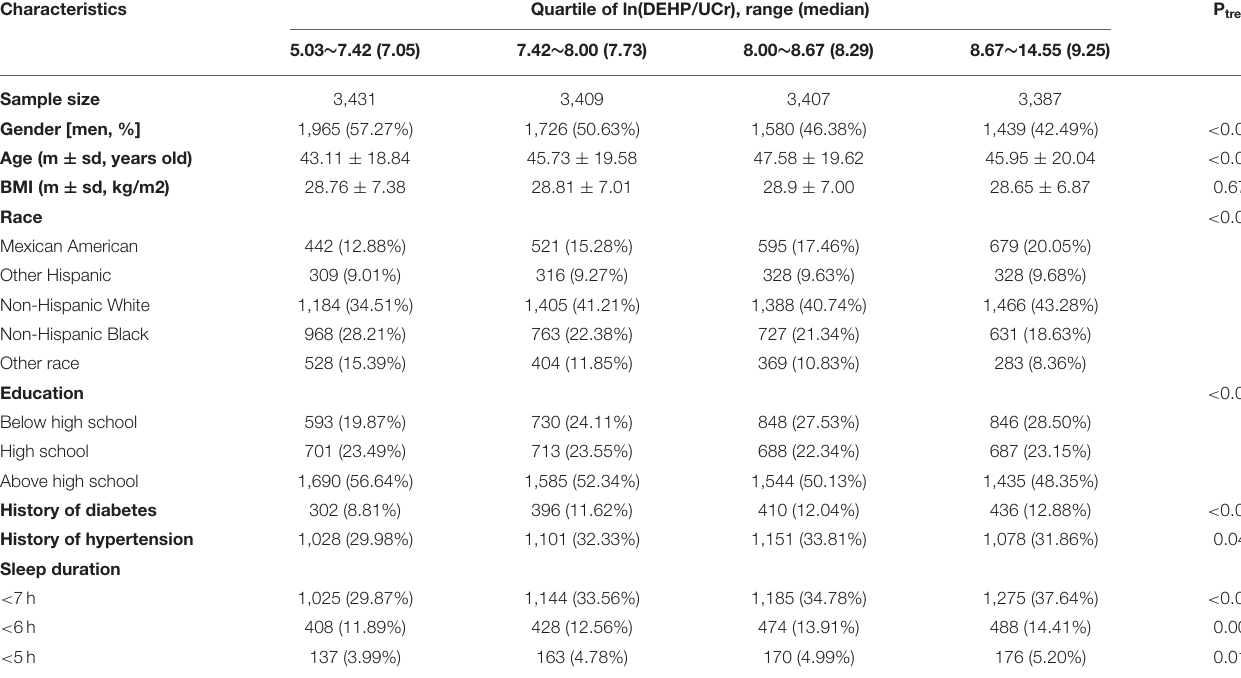
TABLE 2 | The clinical characteristics of the study population according to the concentration of DHEP metabolites in urine.